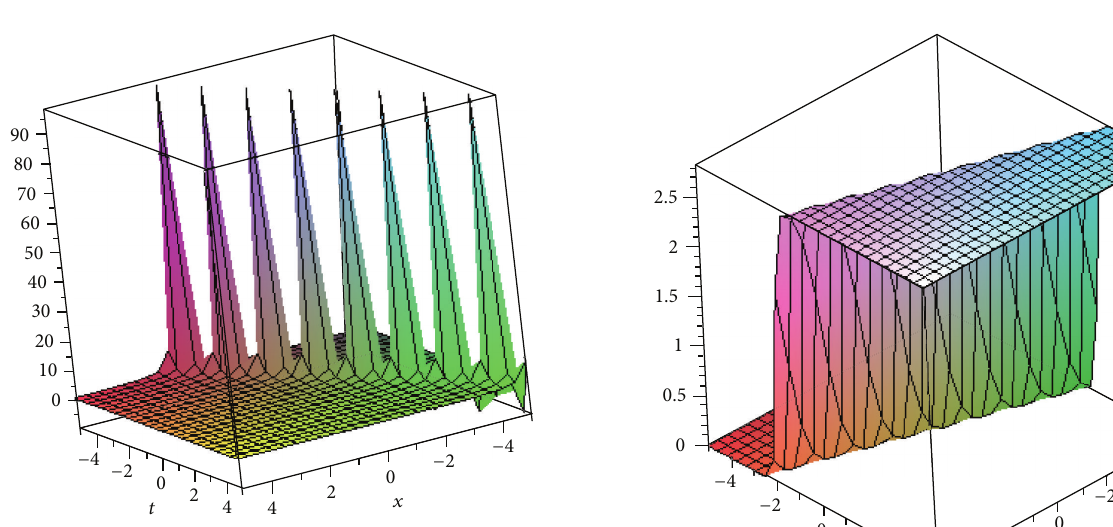
Figure 4: The plot of solution (31) with 𝛽 = 𝑅 = 2 , 𝜇 = 3 , 𝑛 = 1 , and 𝛾 = −1 .